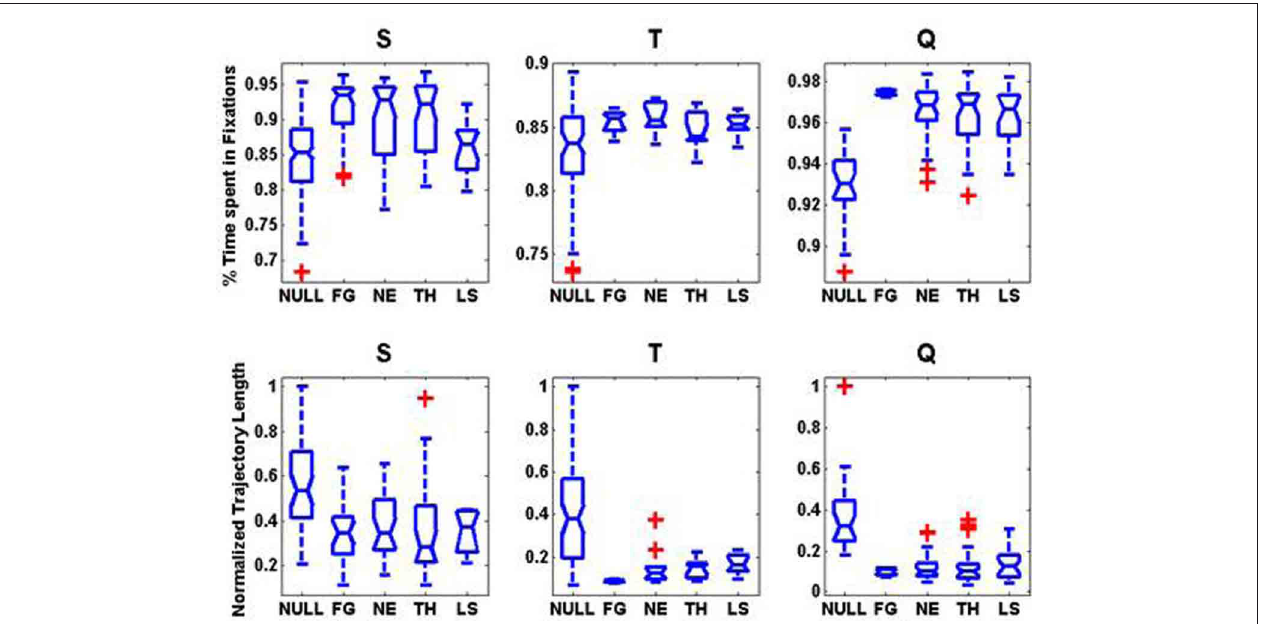
FIGURE 4 | Regardless of the emotional expression, scanpaths over faces are highly stereotyped: boxplots on the statistics on the scanpaths as a function of image category for each monkey. First Row: Distribution of the percentage of total image viewing time spent in fixation.